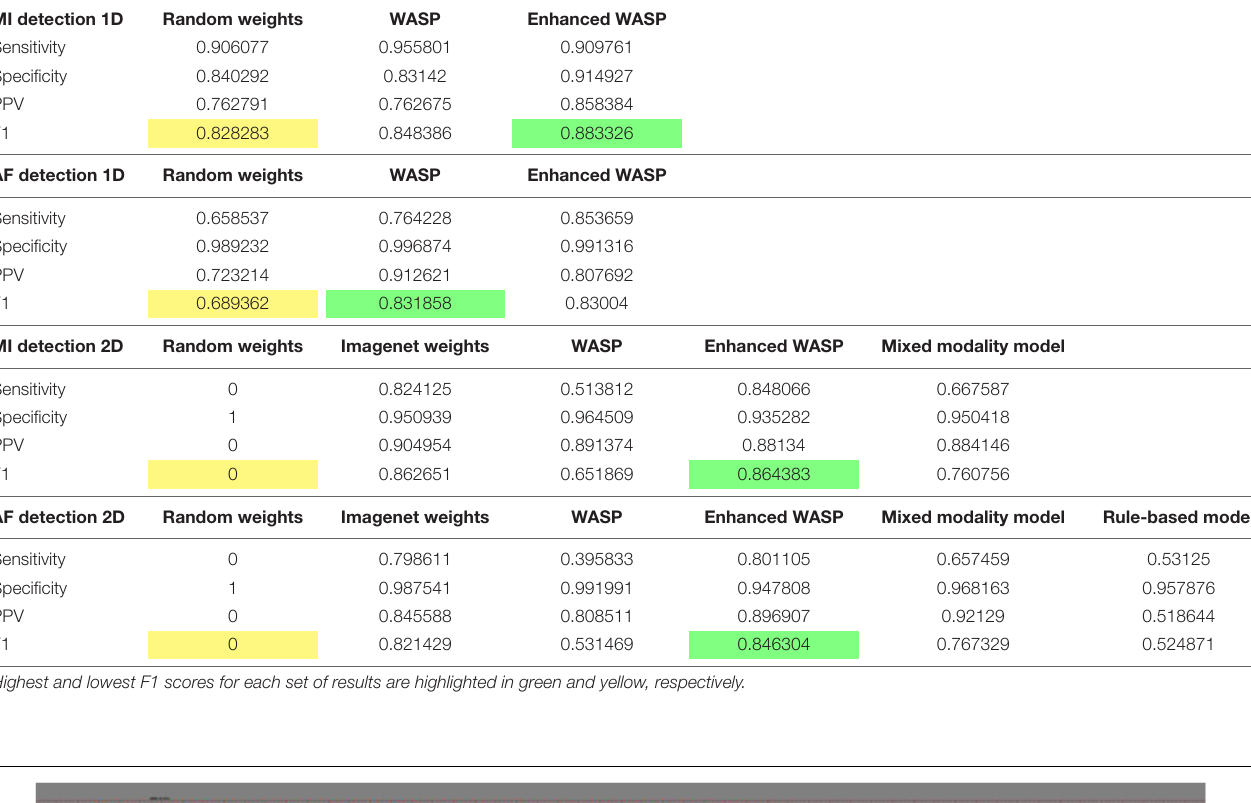
Frontiers in Physiology |